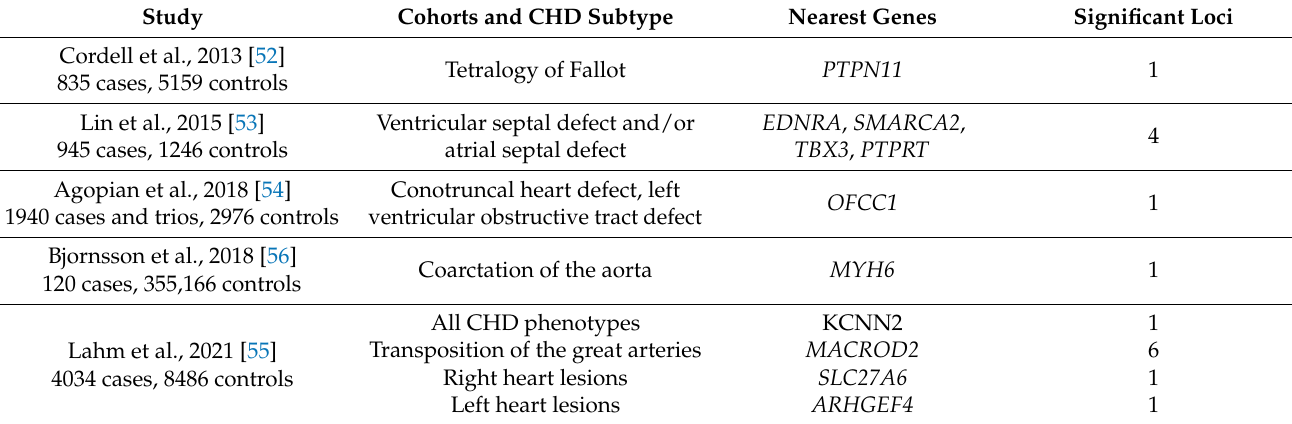
Table 1. Collection of CHD GWAS studies, their significant loci, and nearest